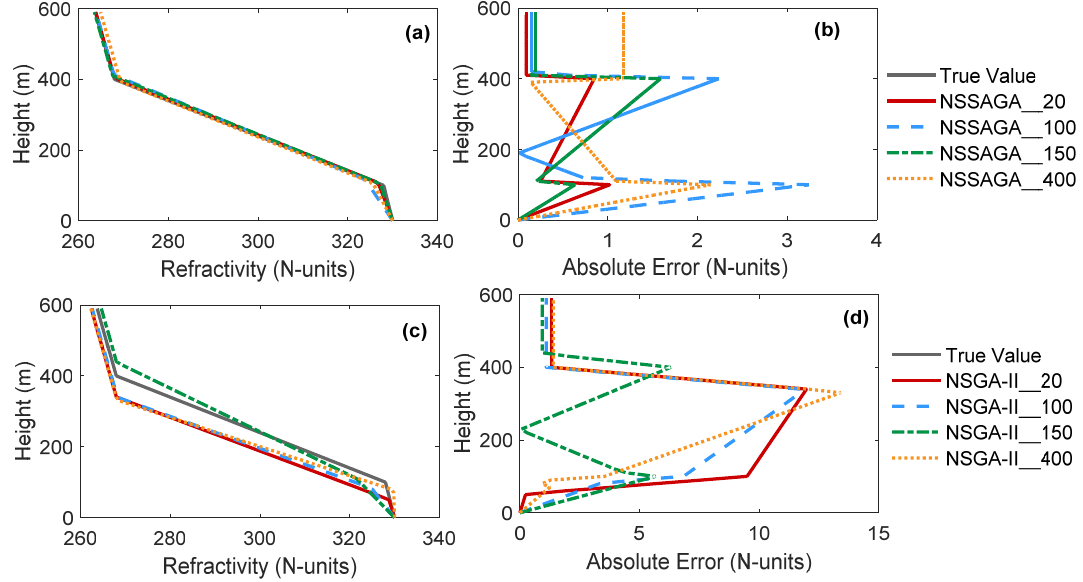
Figure 5. Retrieved refractivity profiles and corresponding absolute error by using ( a , b ) NSSAGA and ( c , d ) non-dominated sorting genetic algorithm II (NSGA-II) with antenna heights of 20 m, 100 m, 150 m, and 400 m.